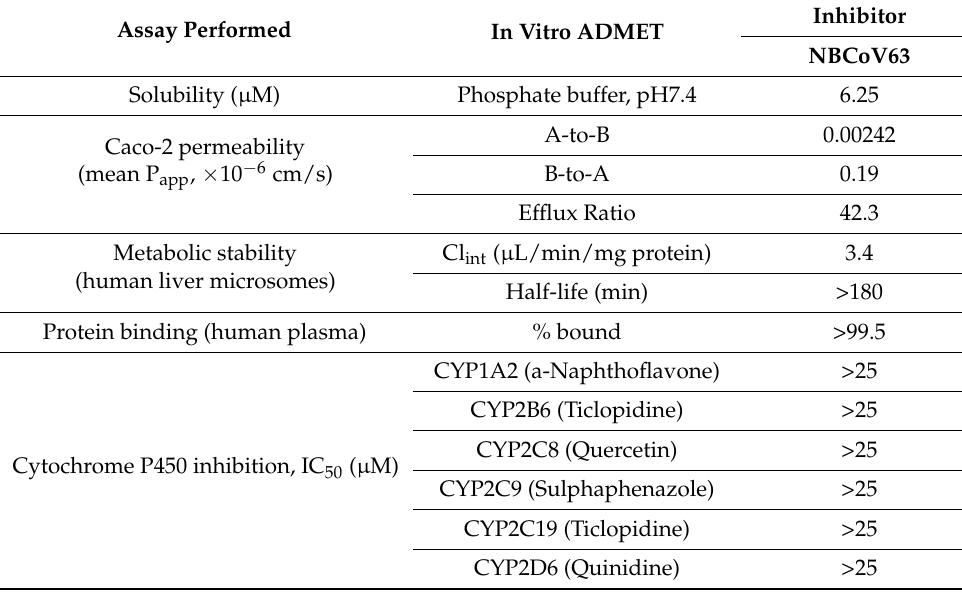
Inhibitor NBCoV63 A-to-B 42.3